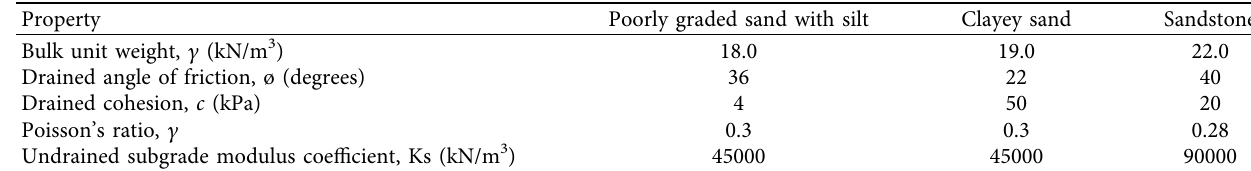
Figure 3: Shoring section 2. Table 1: Mechanical properties of subsurface